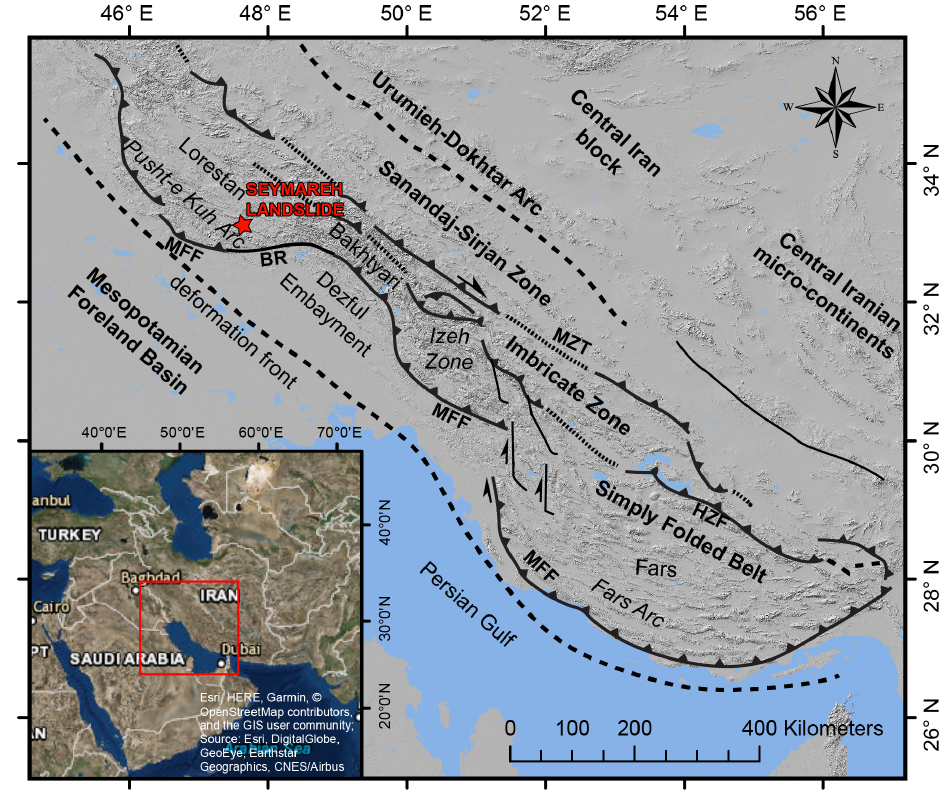
Figure 1. Simplified structural map of the Zagros mountain range with location of the MZT, Main Zagros Thrust; HZF, High Zagros Fault; MFF, Mountain Front Fault; BR, Bala Rud fault zone (modified from Casciello et al., 2009) . © OpenStreetMap contributors 2019.